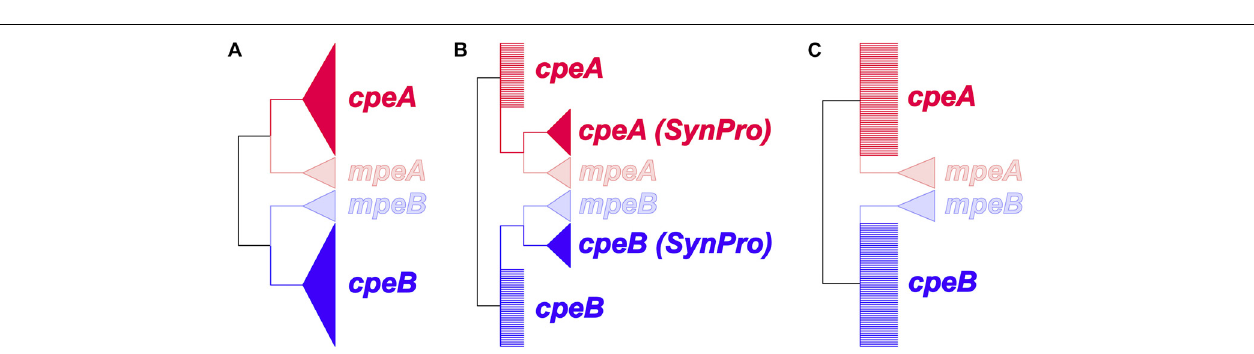
FIGURE 2 | Bayesian phylogenetic tree of cpeBA and mpeBA . PP , posterior probability. Nodes with PP < 0.75 were collapsed. Pigment cluster types are highlighted; only species with a Type III pigment cluster (and Synechococcus spongiarum ) have mpeBA genes.